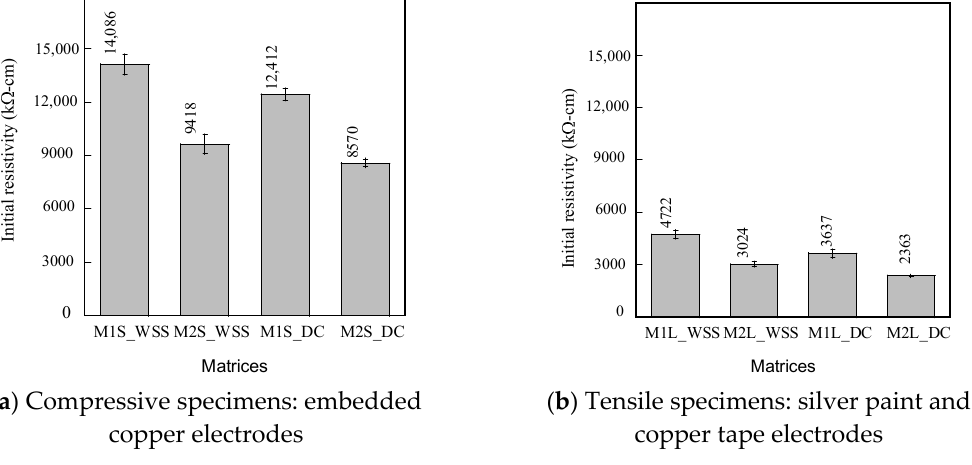
Figure 13. Initial electrical resistivity of S-UHPCs.